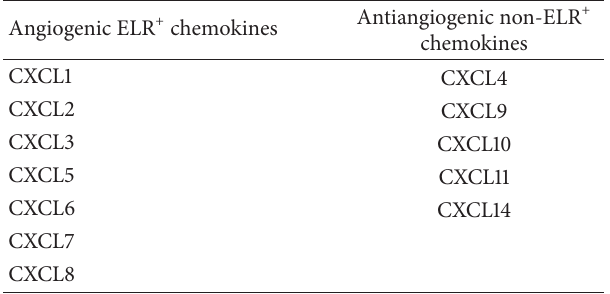
Table 1: Angiogenic and antiangiogenic members of CXC chemokine